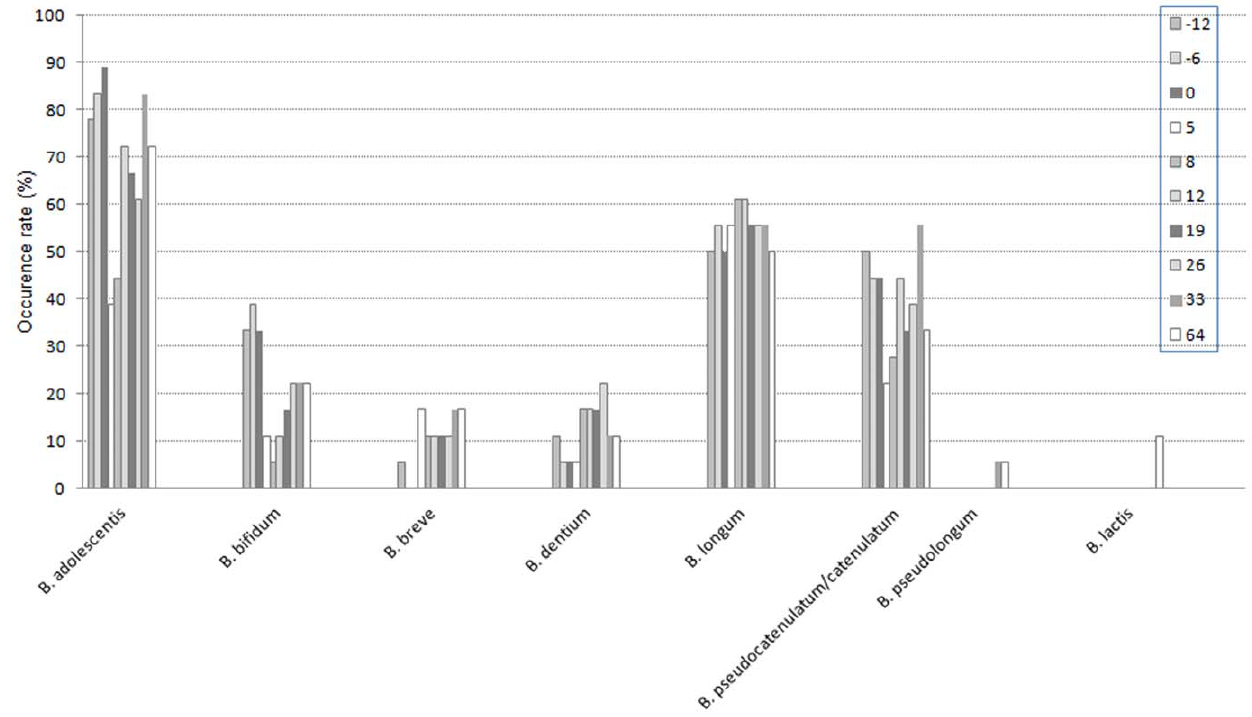
Figure 6. Occurence rate of Bifidobacterium species monitored before and after AMC exposure (day0–day5); n=18 adults.